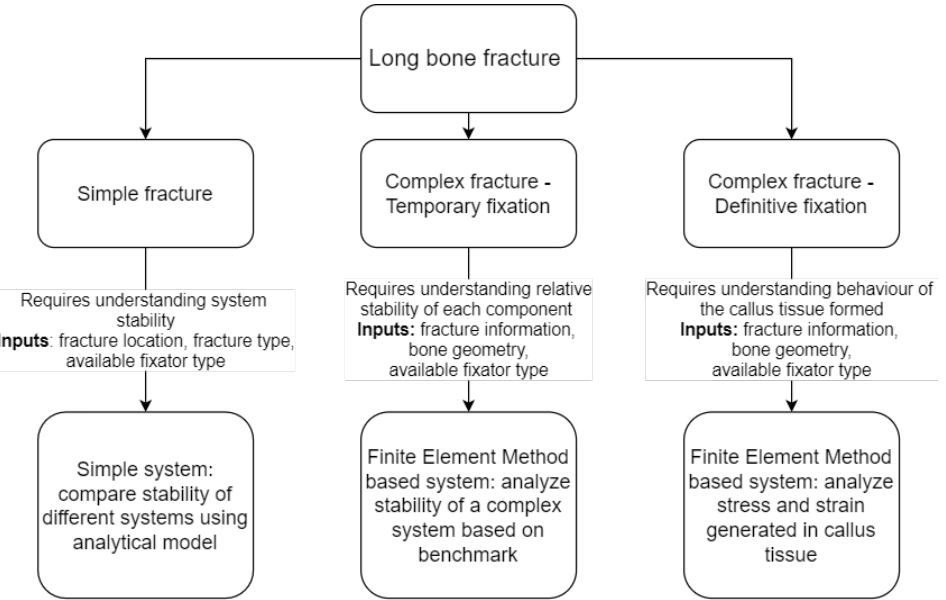
Figure 4. Solution breakdown based on fracture type and fixation requirement.